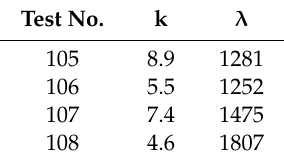
Table 4. The main parameters of wind turbines in full scale.